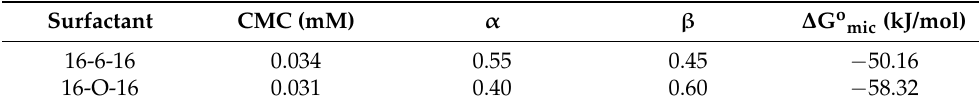
Table 1. Critical micelle concentration, degree of ionization, counterion binding parameter, and Gibbs free energy of micellization in 25 °C.